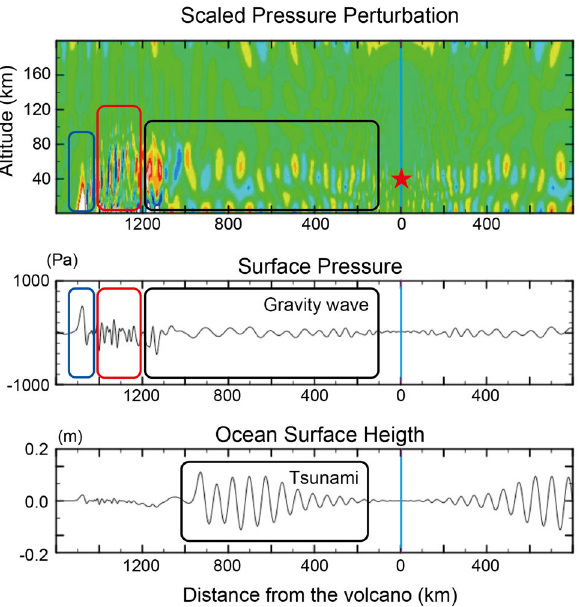
Figure 5. Pressure perturbations and ocean surface height simulated by a hydrodynamic model, including the coupling of the atmosphere and the tsunami. A localized heat source (indicated by a star) is initially given and excites various atmospheric waves. Lamb waves (blue rectangle) propagate at the speed of sound while trapped near the sea surface. Acoustic waves (red rectangle) immediately follow, bouncing between the mesopause (altitude of 100 km) and the sea surface. Then, gravity waves (black rectangle) follow, being trapped below the mesopause. The gravity waves propagate with a variety of velocities depending on the horizontal wavelength and vertical structure, and some of them propagate with a phase velocity of 200 m/s, resonating with tsunamis at ocean depths of 4000 m, resulting in large-amplitude tsunamis (See Supplementary Movie S1 for temporal